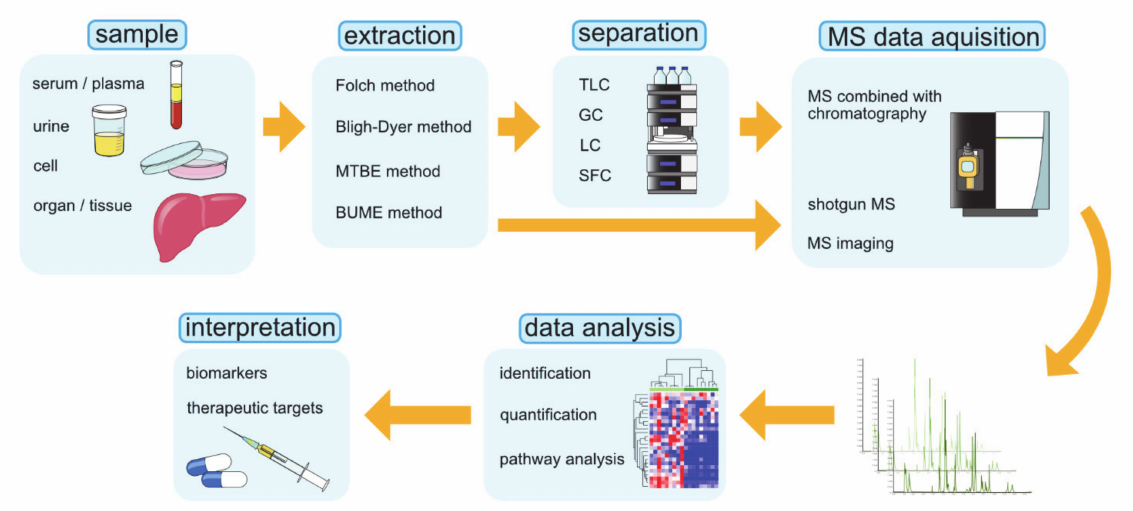
Figure 4. The operating procedures in lipidomics research. BUME, butanol–methanol; GC, gas chromatography; LC, liquid chromatography; MS, mass spectrometry; MTBE, methyl-tert-butyl-ether; SFC, supercritical fluid chromatography; TLC, thin-layer chromatography.